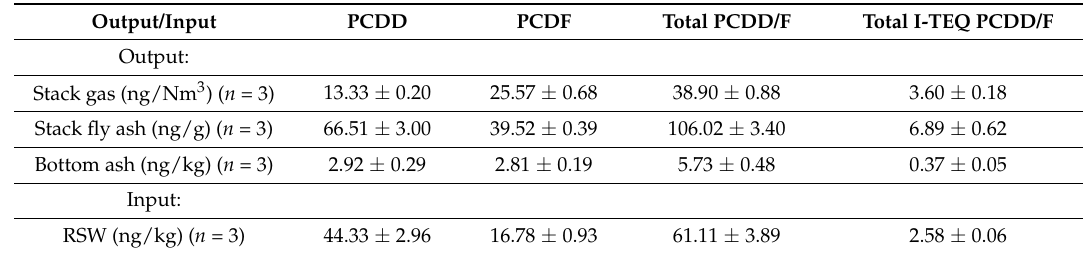
Table 2. Polychlorinated dibenzo- p -dioxin and dibenzofuran (PCDD/F) content in the output and